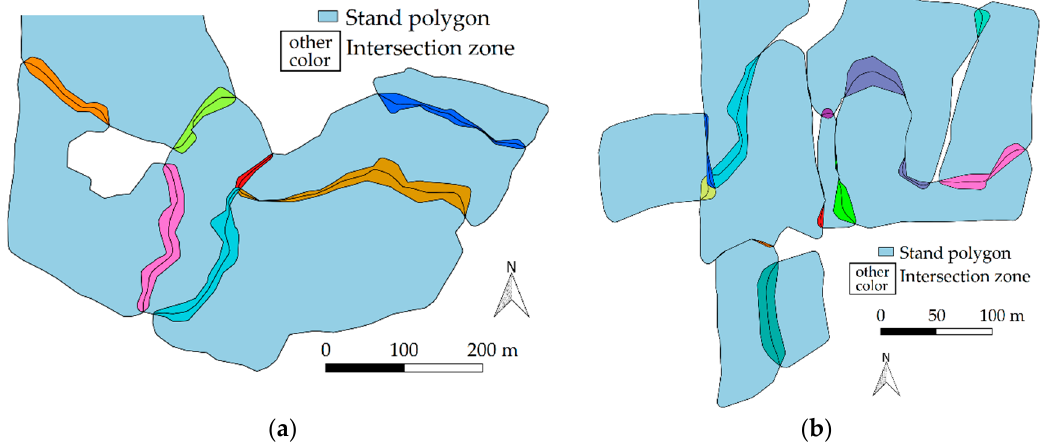
Figure 9. Several adjacent stands are intersecting each other, and Algorithm A3 has provided the solid updated stand boundaries for all of them to the middle of the intersection zones. The stand pair-wise intersection zones are shown in different colors. All stands were harvested with machines with known more accurate GNSS receiver. The ETRS-TM35FIN (EPSG:3067) coordinate system is used in the figure. ( a ) A separate forest stand (area 0.75 ha) lies within the harvested stands. ( b ) Nine intersecting stand geometries are converted into a stand network. The intersections are handled for two stands at a time in the current algorithm. Therefore, the unfilled areas remain between some stands.